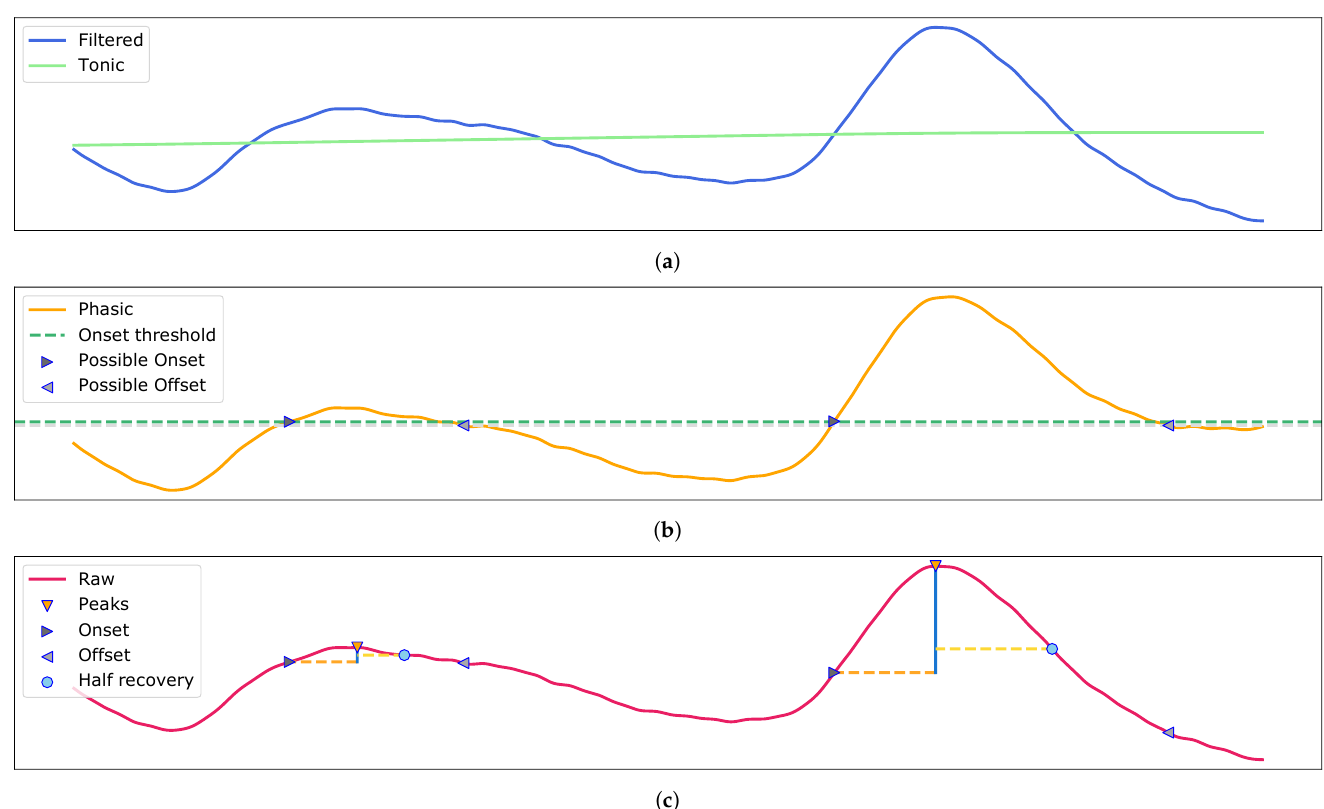
Figure 6. Electrodermal Activity (EDA) decomposition into the phasic and tonic signal with galvanic skin response detection. ( a ) The filtered input and retrieved tonic signal. ( b ) The phasic component with possible on- and offset for the peaks. ( c ) The raw signal with Skin Conductance Response (SCR) and their associated peaks, half recovery, on- and